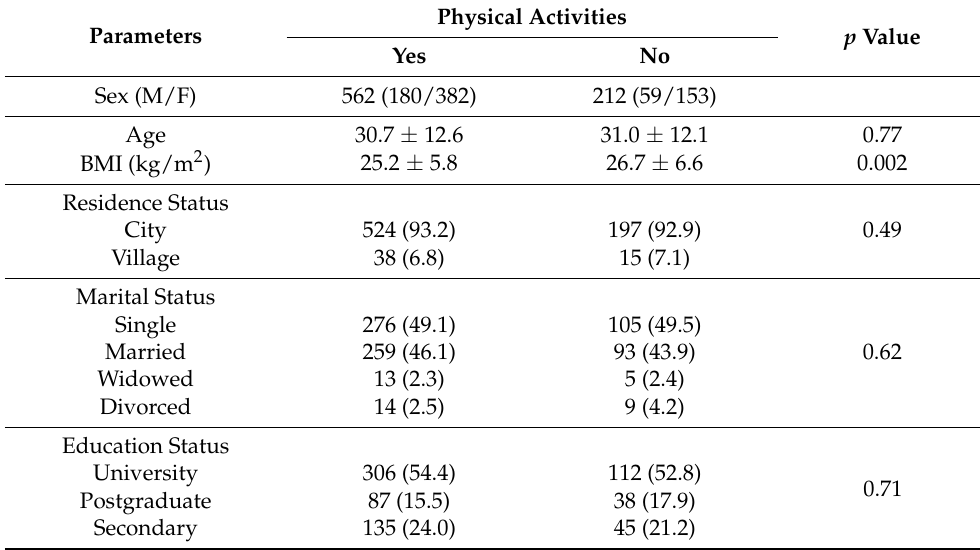
Table 1. Demographic and anthropometric information of the